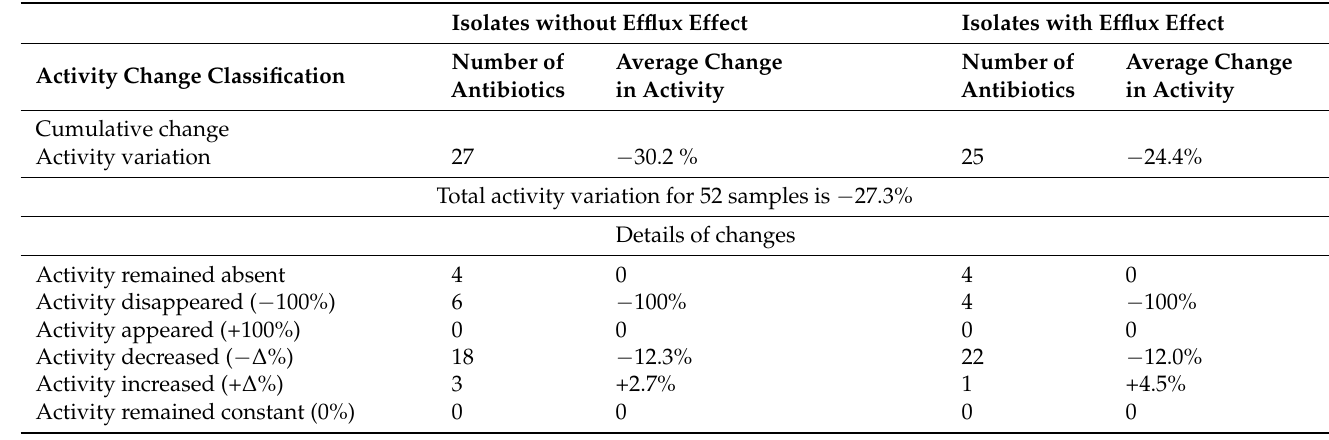
Figure 4. Percentage susceptibility difference (susceptibility after treatment minus susceptibility before treatment) of E. coli to 31 antibiotics: ( a ) Dienomast TM and ( b ) Argovit-C TM treatments; isolates with (circles) and without (squares) an efflux effect. Contribution of isolates having an efflux effect for ( c ) Dienomast TM and ( d ) Argovit-C TM treatments: circles indicate before treatments, and squares indicate after treatments. Table 3. Change in E. coli susceptibility to antibiotics (for isolates with and without efflux effect) caused by Dienomast TM treatment.